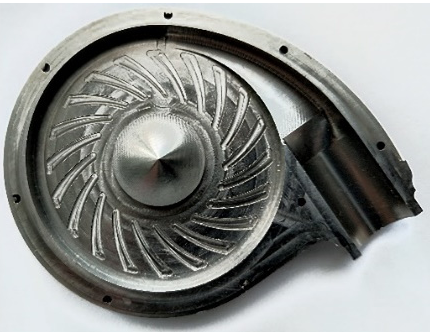
Figure 15. Processed blood pump casing with a hydrodynamic bearing.